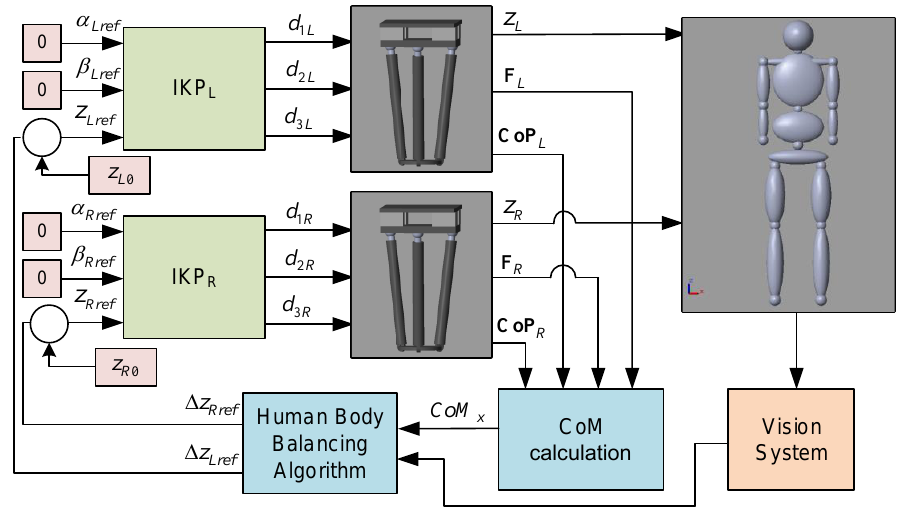
Figure 9. Virtual simulation